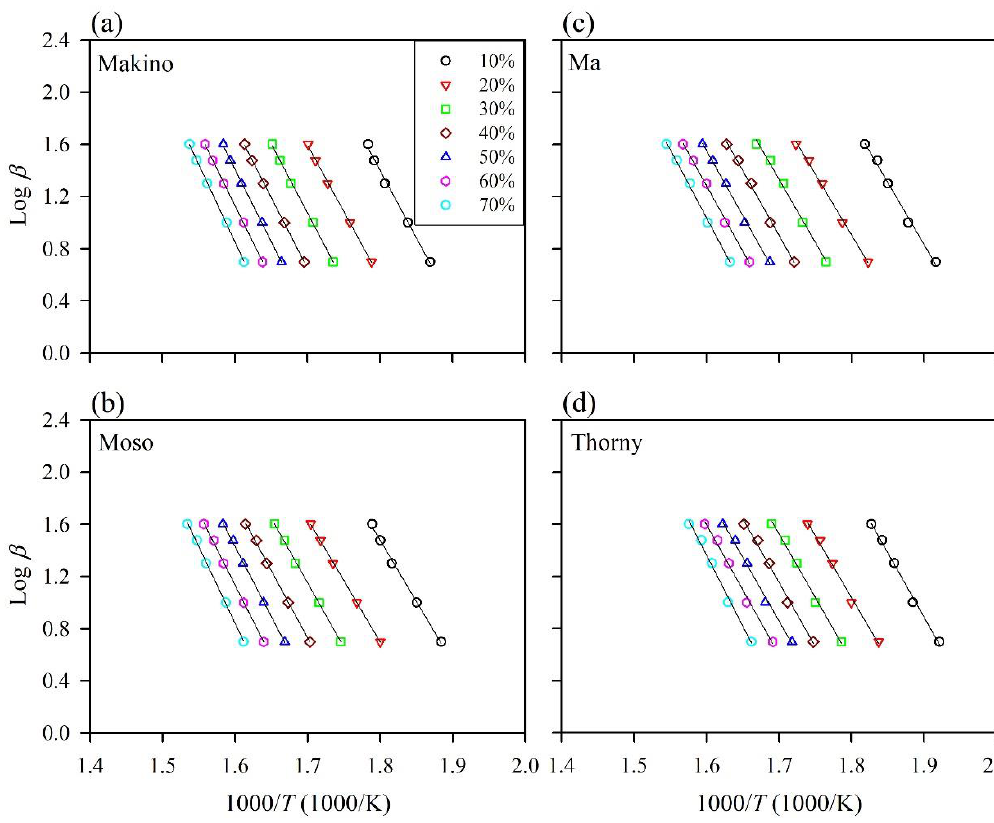
Figure 3. Typical isoconversional plots of various BFs using the Flynn–Wall–Ozawa (FWO) method. ( a ) Makino, ( b ) Moso, ( c ) Ma, and ( d ) Thorny. Table 3. Apparent activation energies of various BFs calculated by the FWO method. Bamboo